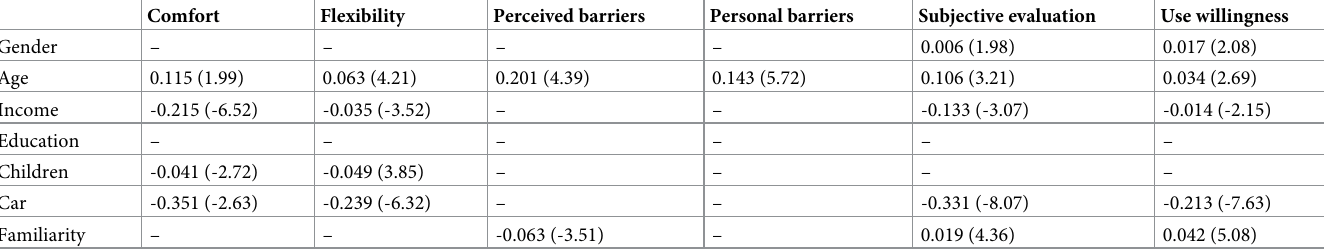
Table 4. The relationship sociodemographic characteristics and psychological latent factors.